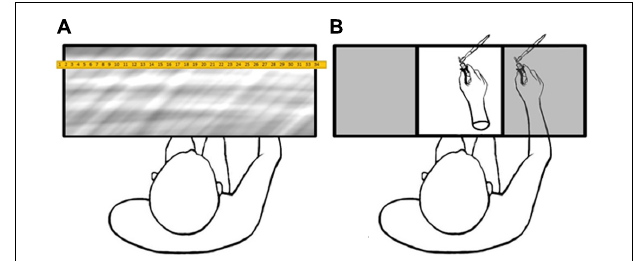
Frontiers in Human Neuroscience |